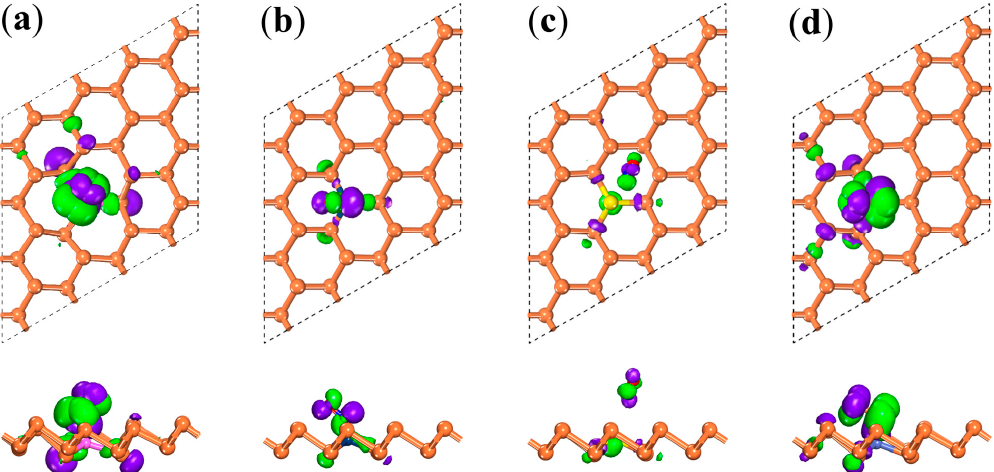
Figure 6. Charge density difference plots for NO adsorbed on ( a ) Al-, ( b ) B-, ( c ) S- and ( d ) Si-doped monolayer arsenene, respectively. The purple (green) distribution denotes the charge accumulation (depletion) with the isosurface of 0.03 e/Å 3 for ( a ) and ( d ); 0.044 e/Å 3 for ( b ) and 0.05 e/Å 3 for ( c ).